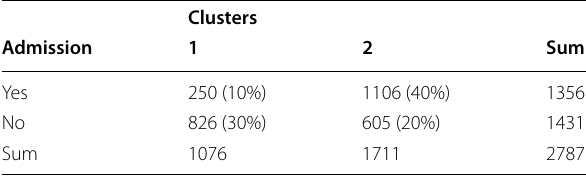
Table 2. The allocation of the 717 ED visits to the COVID department relative to the hospital admission